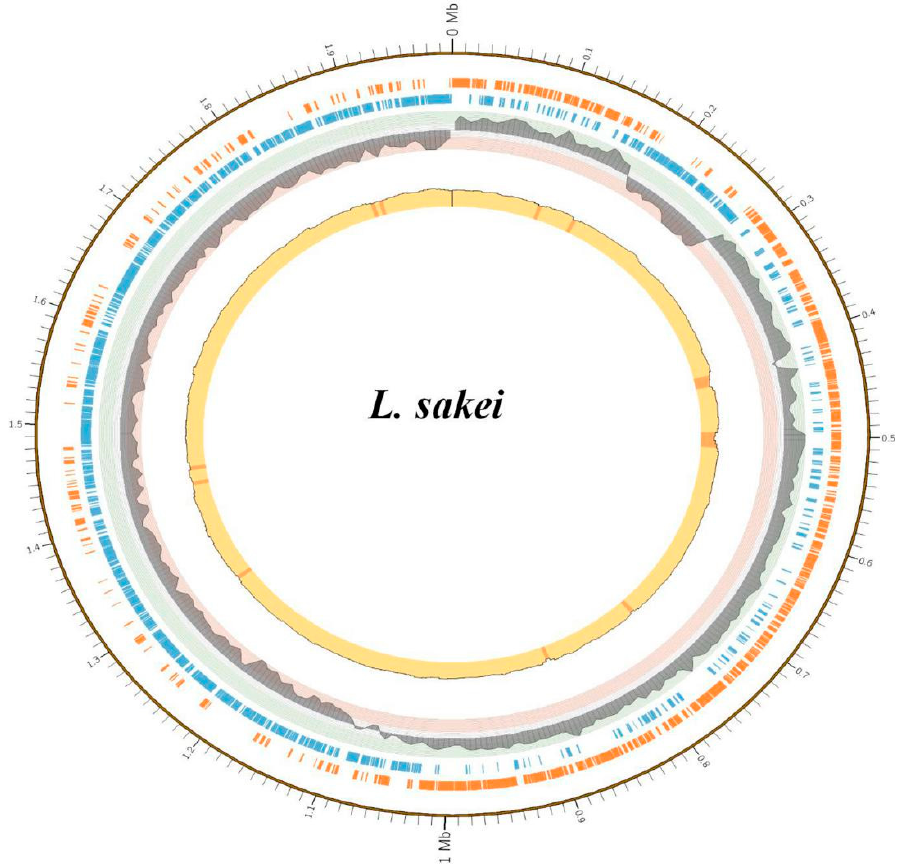
Figure 2. The genome circular map of L. sakei .